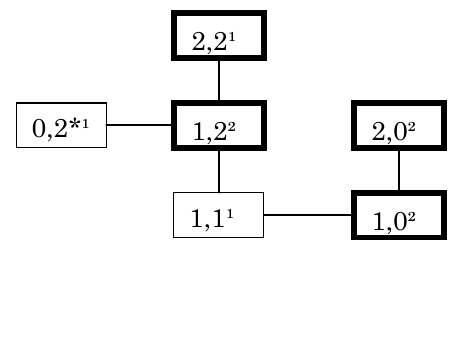
Fig. 4. Evaluation of attribute {a} based on reduct {b,c}